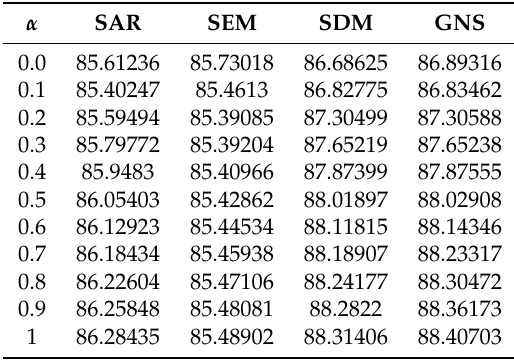
Table 8. Log likelihood for conditional β -convergence models for 2014–2017. The weight matrix